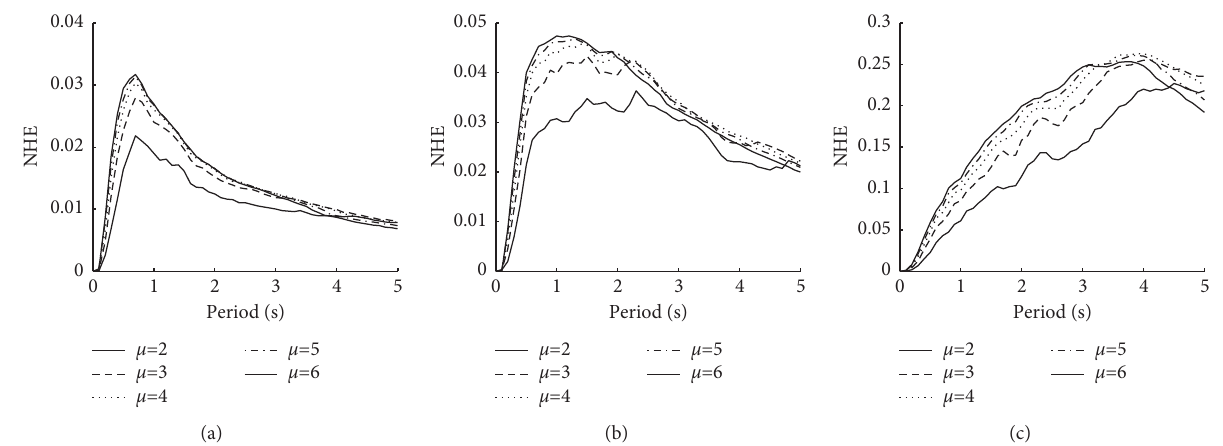
Figure 4: NHE spectra of constant ductility factors ( c � 0 and ξ � 0.05). (a) Hard soil site. (b) Intermediate hard (soft) soil site. (c) Soft soil site.